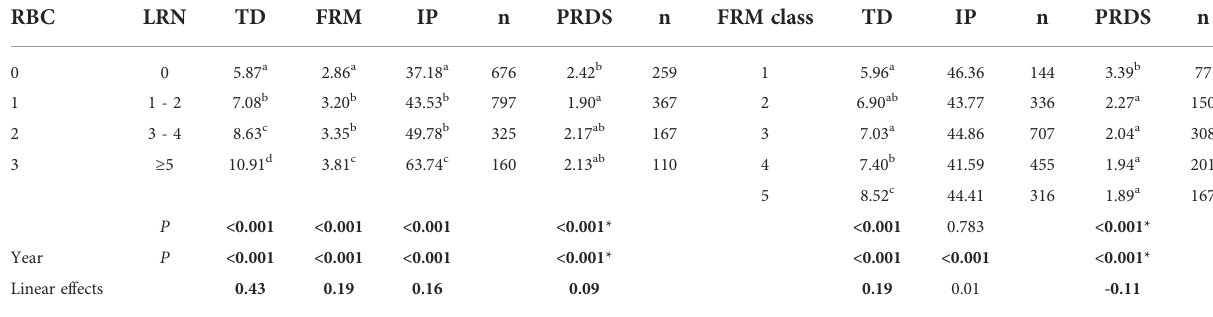
TABLE 6 Effect of root branching (RBC) and fi ne root mass (FRM) class on taproot diameter (TD), fi ne root mass score (FRM), ratio of infected plants (IP, as %), plant root disease score (PRDS) and lateral root number (LRN) measured as individual plants averaged across all locations and